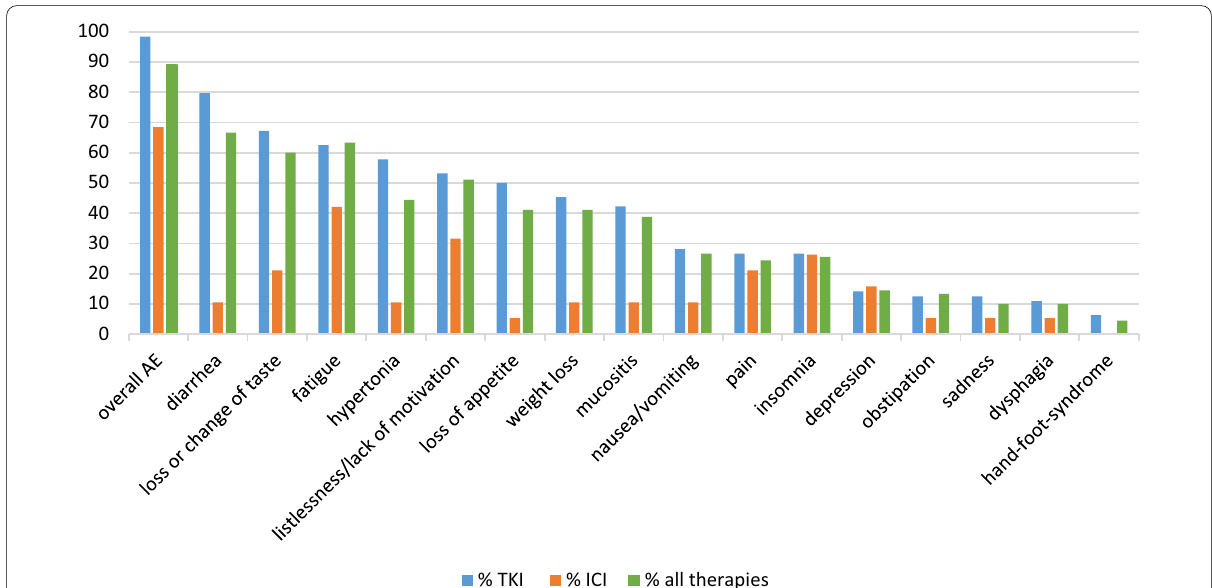
Fig. 1 Percentage of side effects according to type of therapy (all: n Green filled square % all